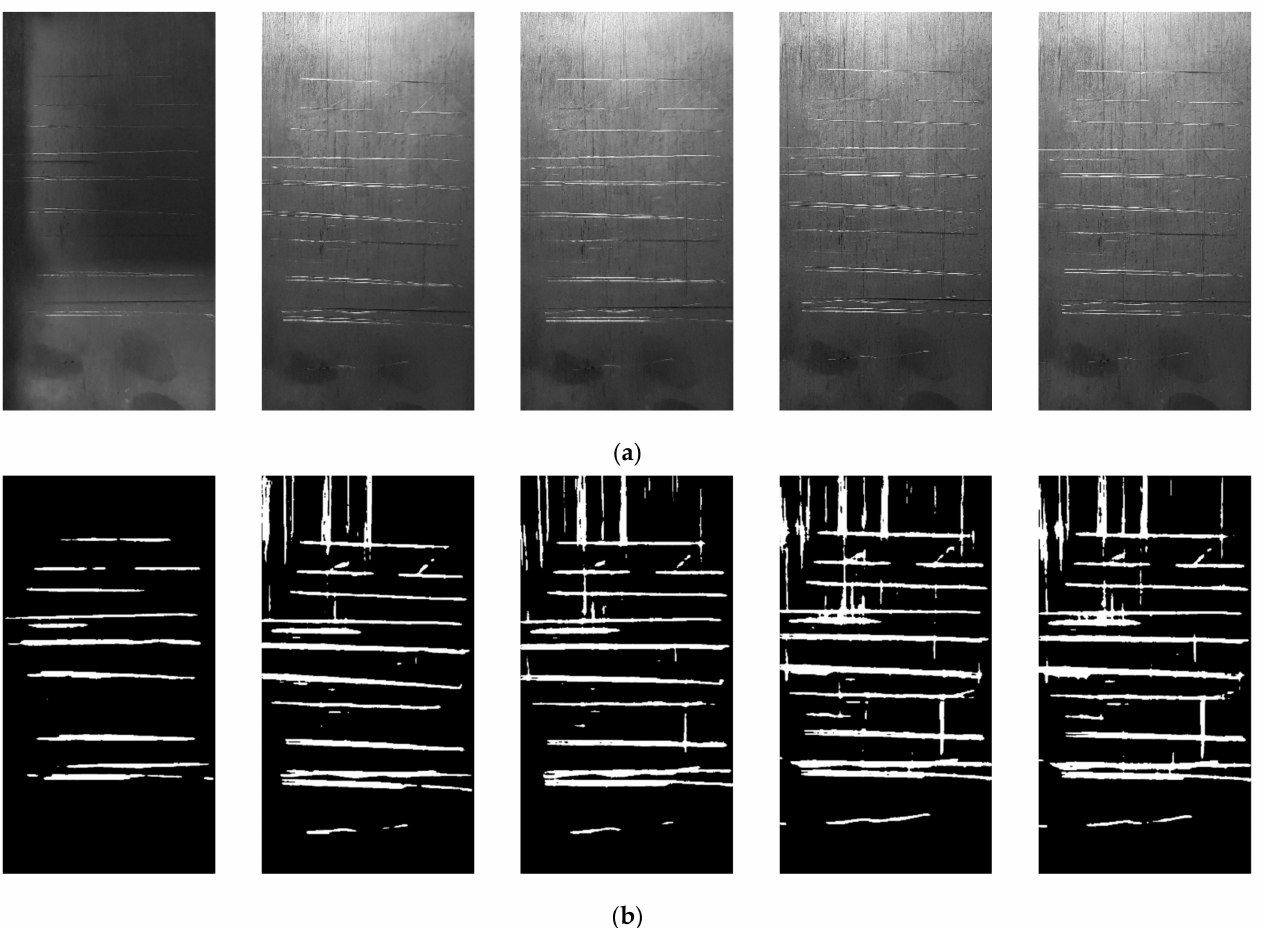
Figure 7. Initial images of zone I ( a ) and images detected on them ( b ) at light levels of 2, 50, 100, 500, and 800 lx, respectively.